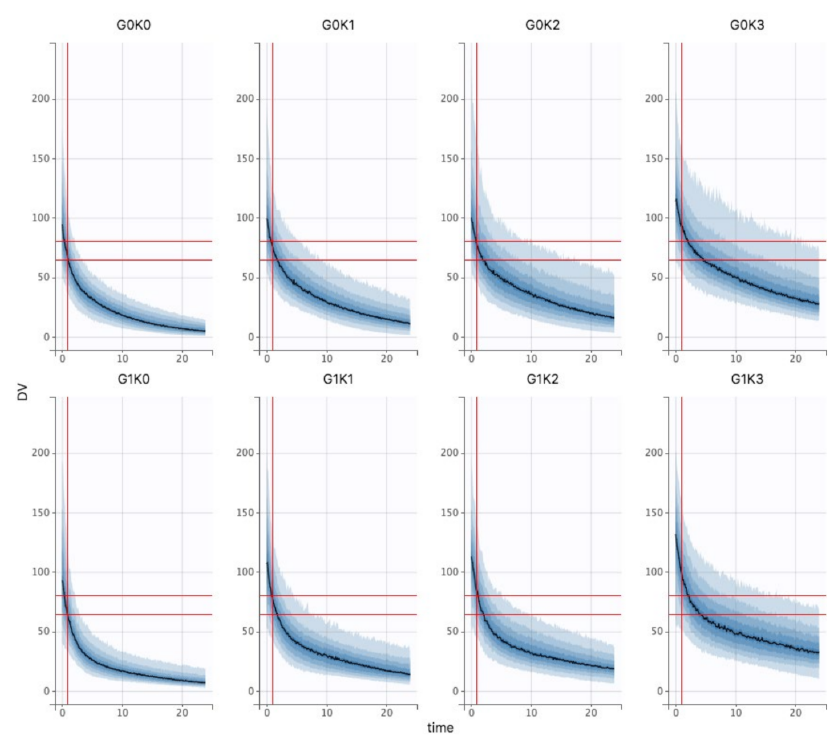
Figure 3. Bayesian estimates of the final model in control (top row) and V-A ECMO (bottom row) patients as a function of KDIGO stage